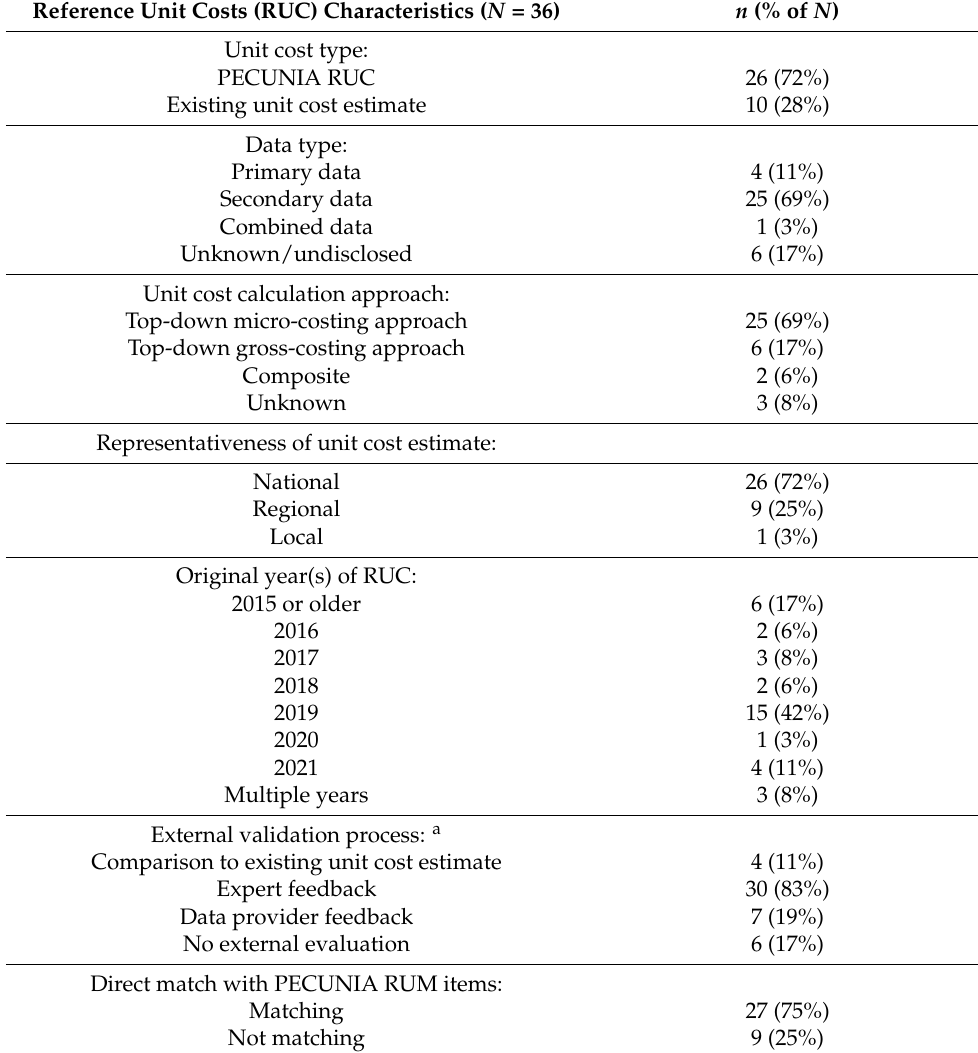
Table 1. Summary statistics on the main characteristics of the 36 PECUNIA reference unit cost (RUC) estimates for health and social care